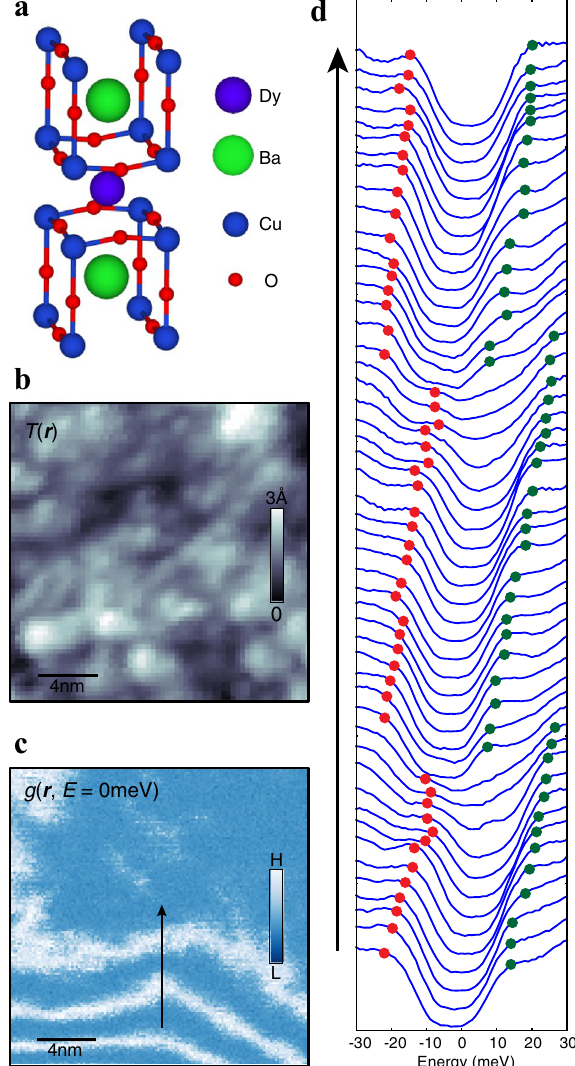
Figure 1. DyBa 2 Cu 3 O 7-δ topography and LDOS spectra. ( a ) Crystal structure of DyBa 2 Cu 3 O 7-δ . ( b ) Typical STM topography of a 20 nm × 20 nm FOV, measured at V bias = 150 mV and I = 50pA. ( c ) Differential conductance map, g ( r , E = 0 meV) in a 20 nm × 20 nm FOV measured at V bias = 150 mV and I = 150pA. ( d ) A line cut through the black solid arrow in c . The spectral shift in energy is obvious. Red and green solid dots indicate the negative and positive energy peak/kink positions of the superconducting gap